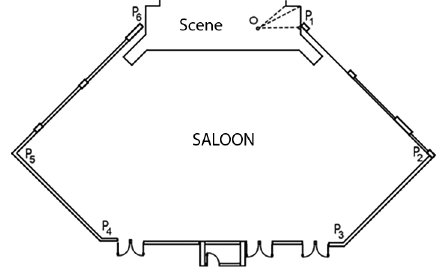
Figure 1. The indoor space station ( P ), connection (1) and survey points (2, 3, …, 8)